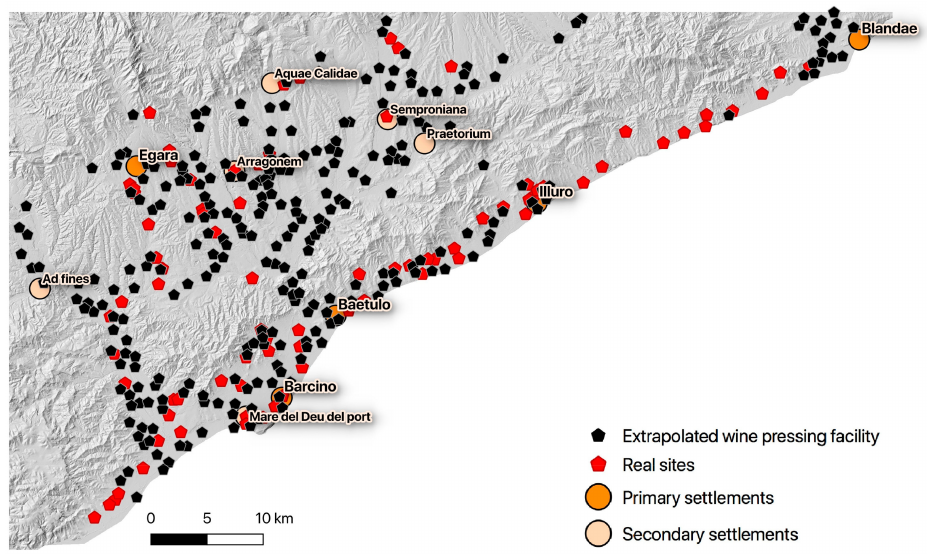
Figure 11. Distribution of 360 potential wine pressing facilities over the suitability area S ≥ 0.5, predicted by